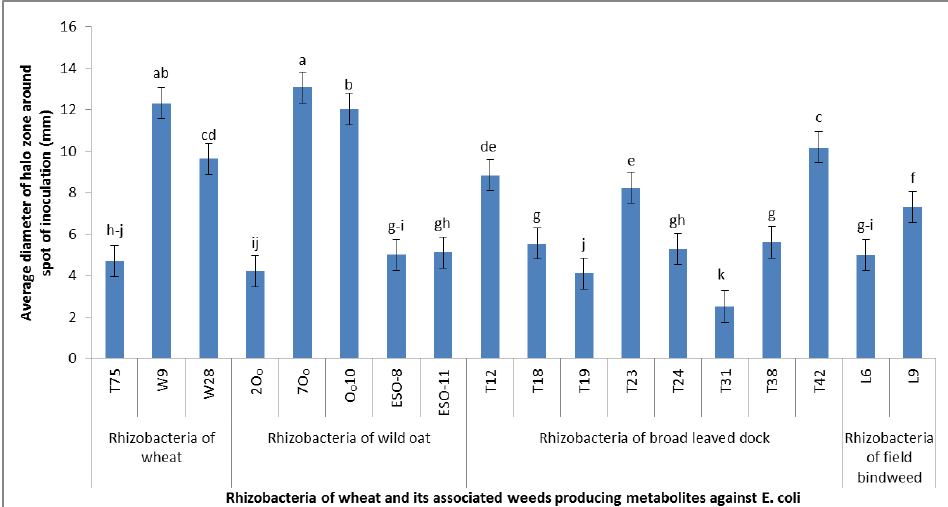
Figure 3. Cyanogenic rhizobacteria of weeds and wheat-producing metabolites against E. coli in the antimetabolite assay.